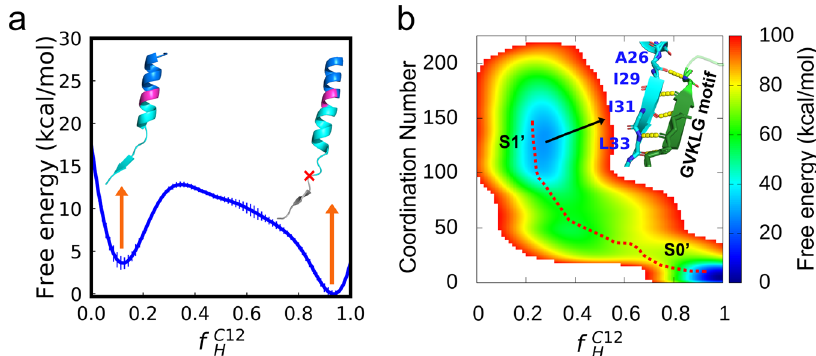
Fig. 7 Unwinding and binding are necessary for successive delivery of cleavage sites on the APP TMD into the catalytic site of PS1. a Free energy pro fi le of unwinding as a function of residual helicity for the C12 region of the A β 49 TMD. Uncertainty is estimated with block analysis. b 2D free energy pro fi le as a function of residual helicity for the C12 region of the A β 49 TMD and the binding states between PS1 and the A β 49 TMD. The local minimums in the A β 49 recognition process are labeled S0 ’ and S1 ’ , and interactions between the GVKLG motif and the -IVIT- region in state S1 ’ are represented by yellow dashed